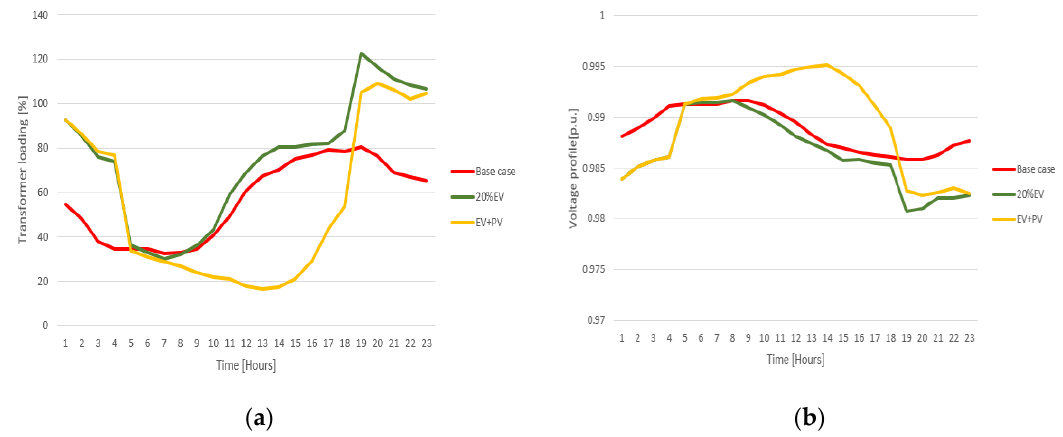
Figure 8. Comparison of urban ( a ) transformer loadings and ( b ) most loaded feeder voltage profiles with 20% electric vehicle (EV) penetration.